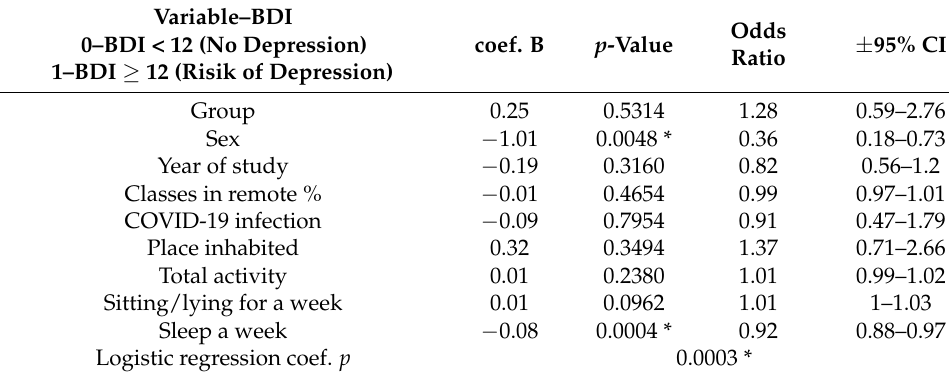
Table 11. Logistic regression calculated for the risk of depression (BDI ≥